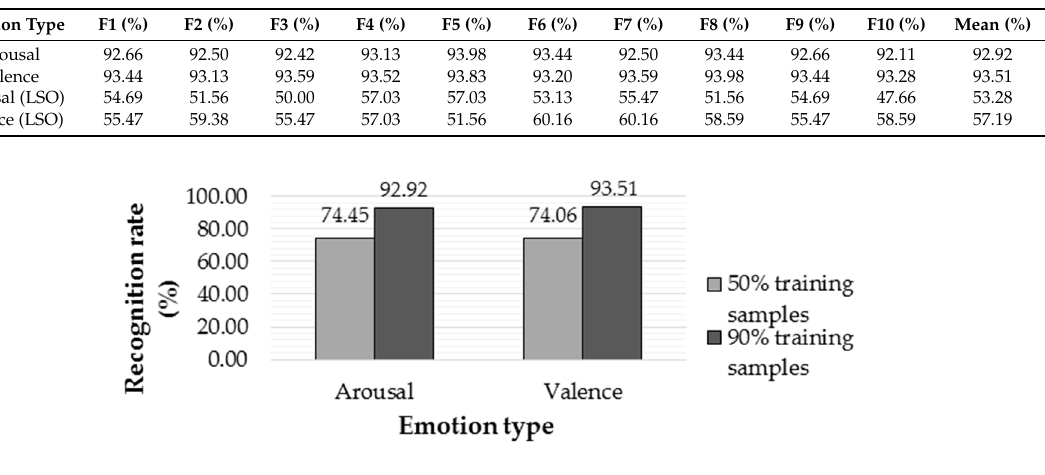
Figure 5. Recognition rate for different amounts of data training samples.